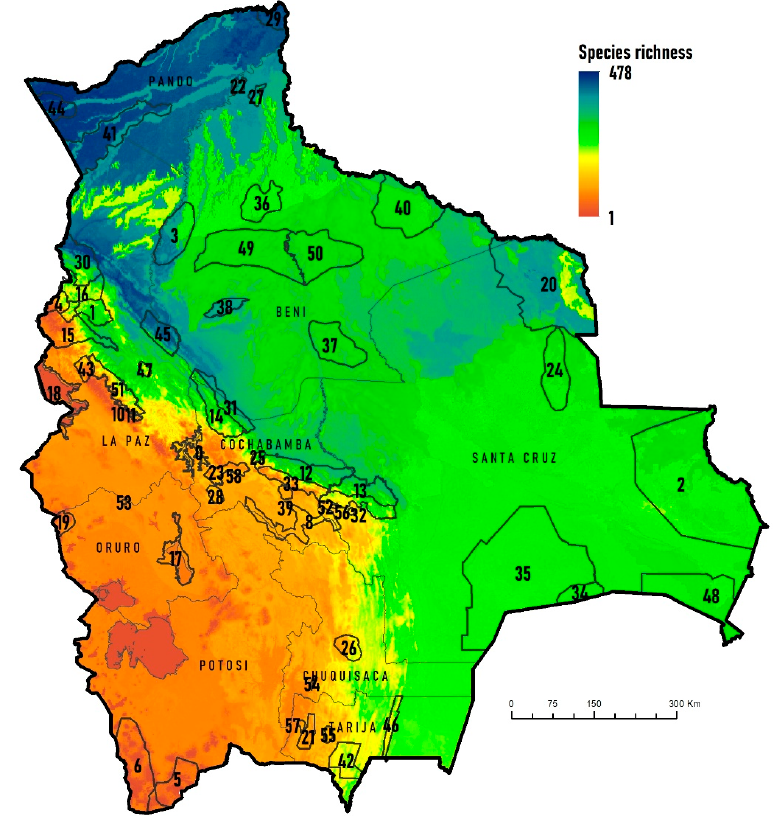
Figure 3. Total bird species richness in relation to the KBAs of Bolivia. Table 1. Maximum pixel value of 1’ × 1’ for total, endemic and threatened bird richness in the KBAs of Bolivia.